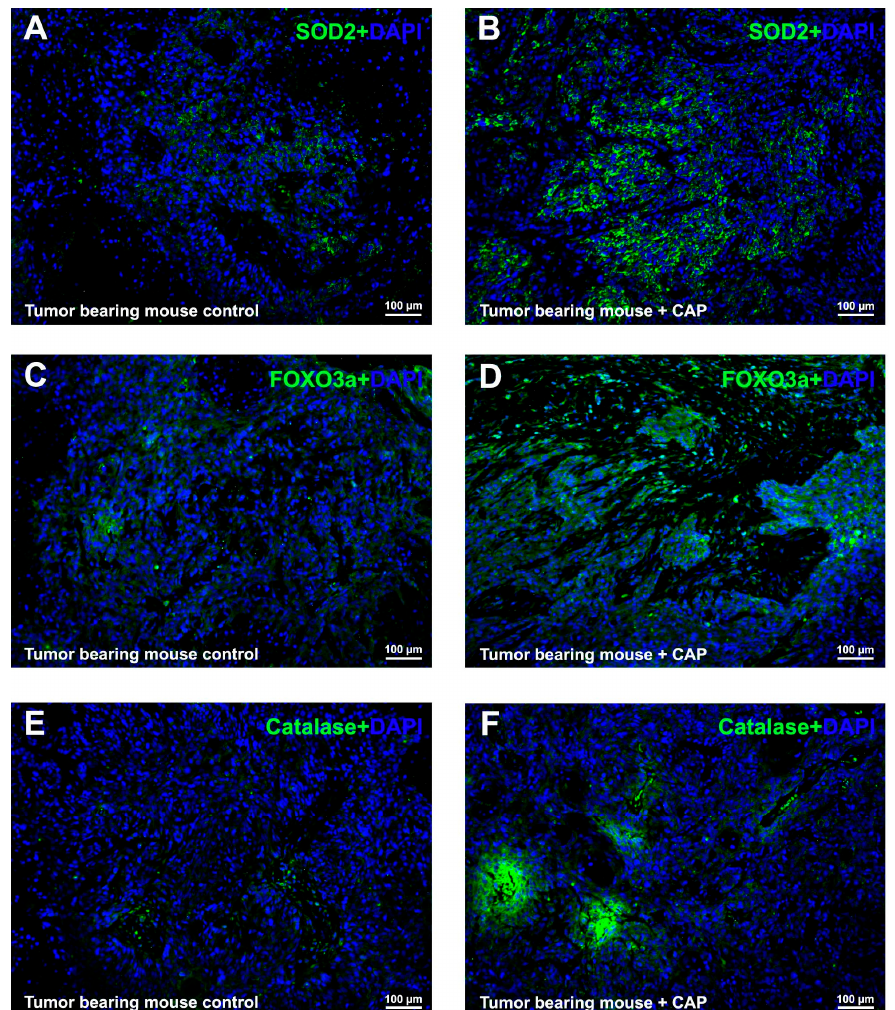
Figure 5. CAP induced strongly upregulation of proteins involved in ROS metabolism in vivo. Representative immunofluorescence staining revealed a strongly increasing of proteins involved in ROS metabolism, SOD2 (green, A , B ); FOXO3a (green, C , D ) and Catalase (green, E , F ); in the tumor bearing mice control ( A , C , E ) and CAP injection ( B , D , F ) tissues. Nuclei were stained by DAPI (blue). The scale bar for A – F are 100 µm.